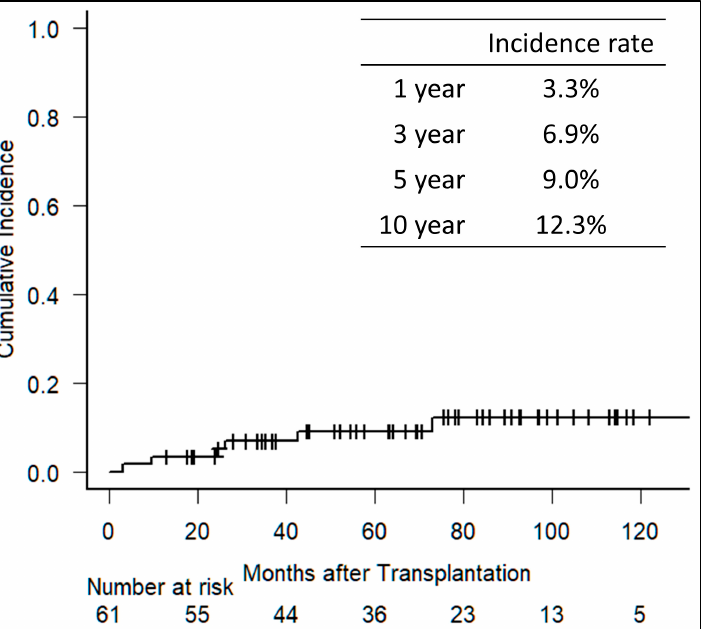
Figure 2. Cumulative incidence of CN in patients with pancreatic transplantation . The cumulative incidence rates at 1, 3, 5, and 10 years after transplantation were 3.3, 6.9, 9.0, and 12.3%, respectively.